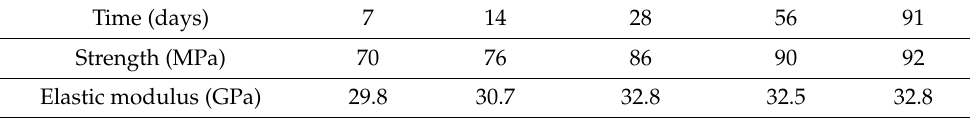
Table 3. Compressive strength and elastic modulus of SCC at various days.